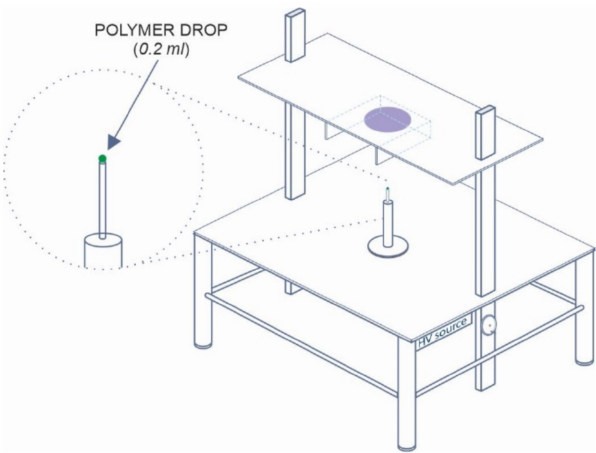
Figure 1. Schematic sketch of the needleless electrospinning